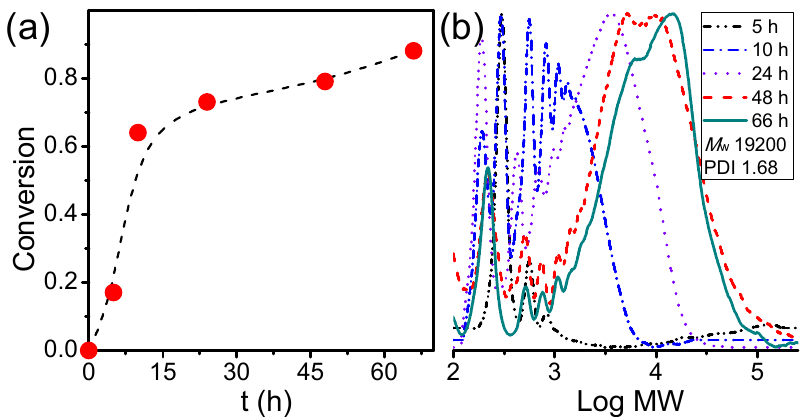
Figure 1. Kinetics of atom transfer radical polyaddition (ATRPA) of 4-vinylbenzyl 2-bromo-2-phenylacetate (VBBPA): ( a ) conversion vs. t and ( b ) evolutions of molecular weights (MW) (VBBPA/CuBr 2 /Cu/ dNBpy = 50/2/1/6 at 40 °C; [VBBPA] 0 = 1.8 M in anisole).